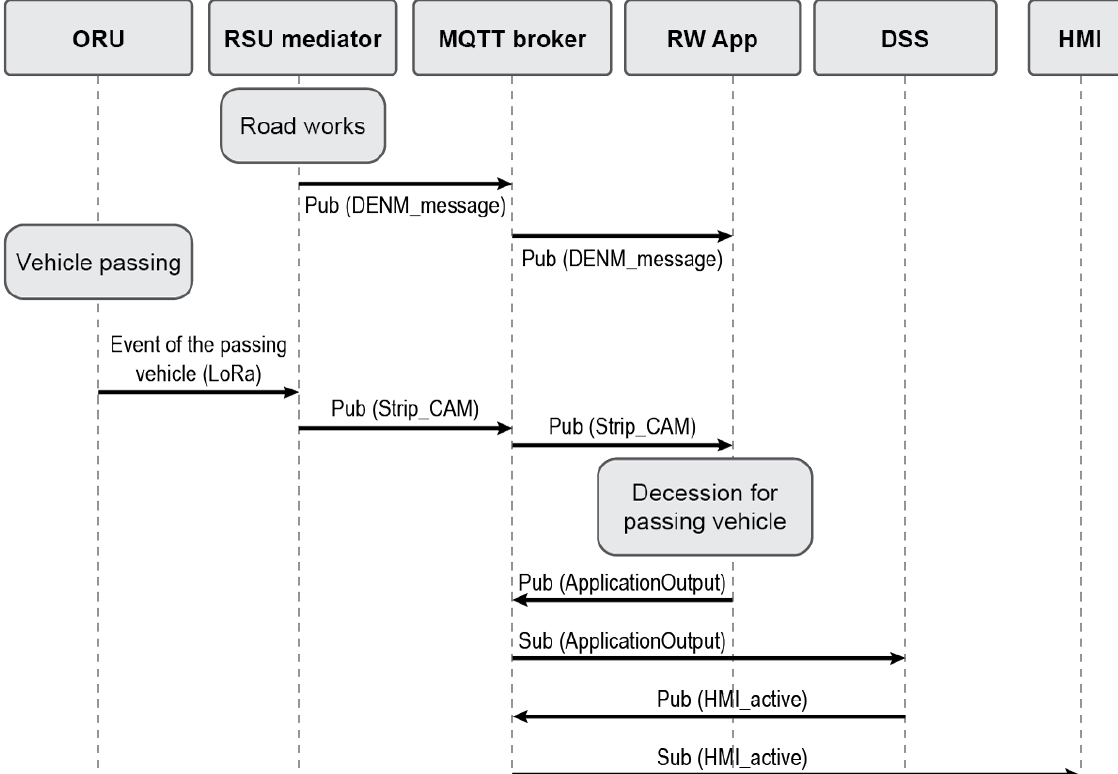
Figure 3. Warnings & messages flow architecture example.